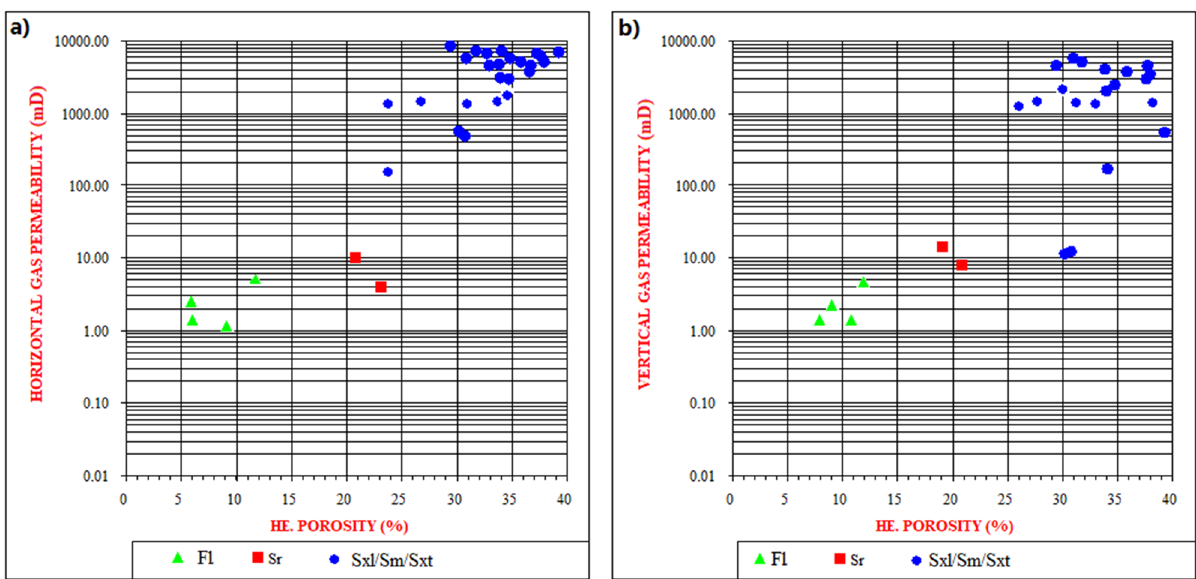
Figure 9. A clear relationship between reservoir quality and the various facies present in the cored intervals. The best reservoir quality is associated with the coarser grained, moderately sorted and high-energy channel sandstones (Facies Sxl, Sm, Sxt), whereas the fine and clay-rich facies (Facies Fl, Sr) display poor reservoir